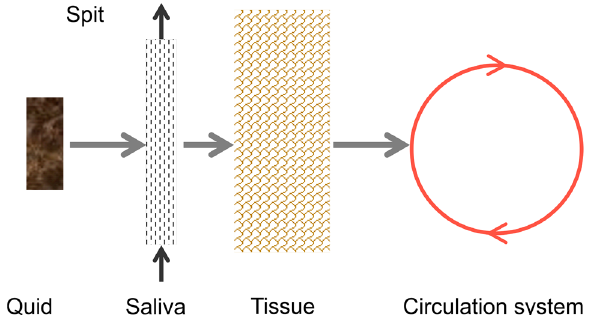
Figure 4. Process for release and transport of nicotine from a smokeless product, including dissolution in saliva, dilution by saliva, intermittent expectoration and or swallowing and permeation through the tissue.